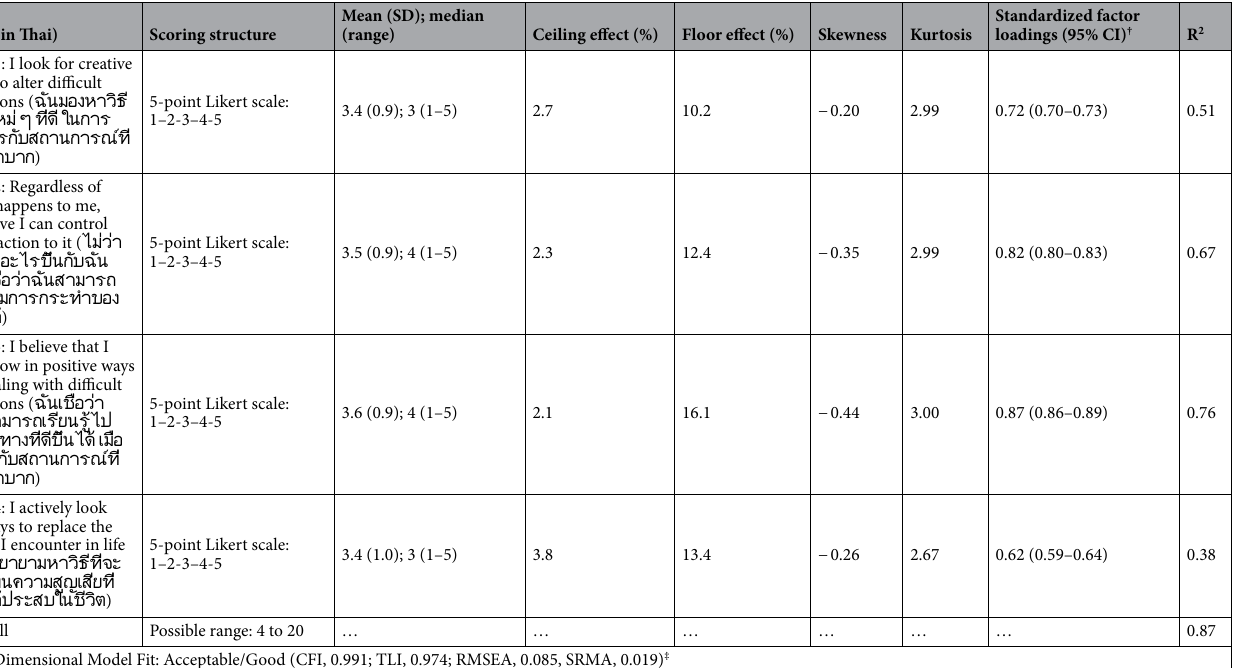
Table 2. The Thai-BRCS version questionnaire and standardized factor loading (n = 2002). † Based on standardized confirmatory factor analysis. ‡ Threshold for acceptable fit: CFI, > 0.9; TLI, > 0.9; RMSEA, < 0.1; SRMR, < 0.1. BRCS Brief Resilient Coping Scale, CFI comparative-fit index, RMSEA root mean square error of approximation, SD standard deviation, SRMR standardized root mean squared residual, TLI Tucker-Lewis index.